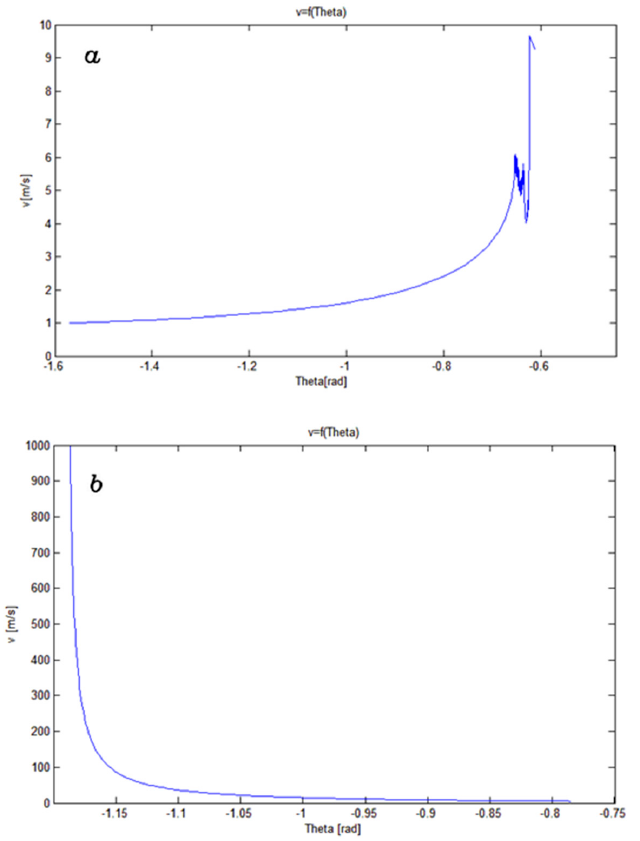
Figure 5. Incorrect solutions to the problem. ( a ) A loss of solution stability for v 0 = 1.0 m/s, α = − 45°, v c = 7.0 m/s, v f = 10.0 m/s, β = 90°; and ( b ) runoff of the solution toward infinity for v 0 = 5.0 m/s, α = − 45°, v c = 10.5 m/s, v f = 10.0 m/s, β = 0°.